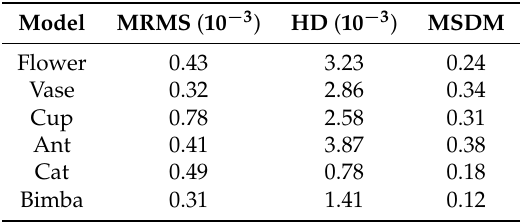
Table 3. Watermark imperceptibility measured in terms of maximum root mean square error (MRMS), HD, and mesh structural distortion measure